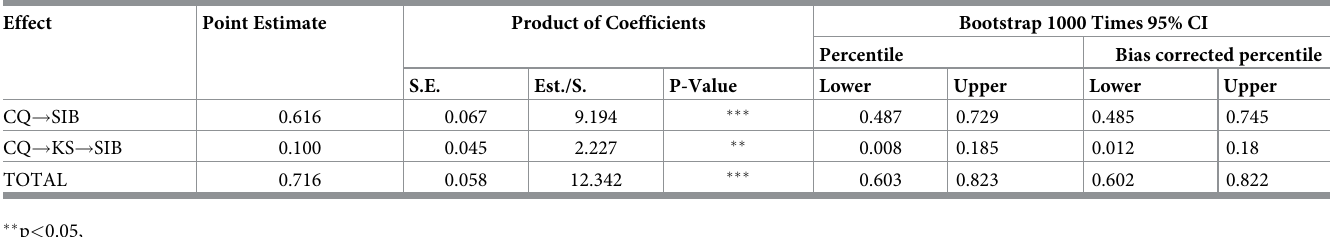
Table 6. The mediating test of knowledge